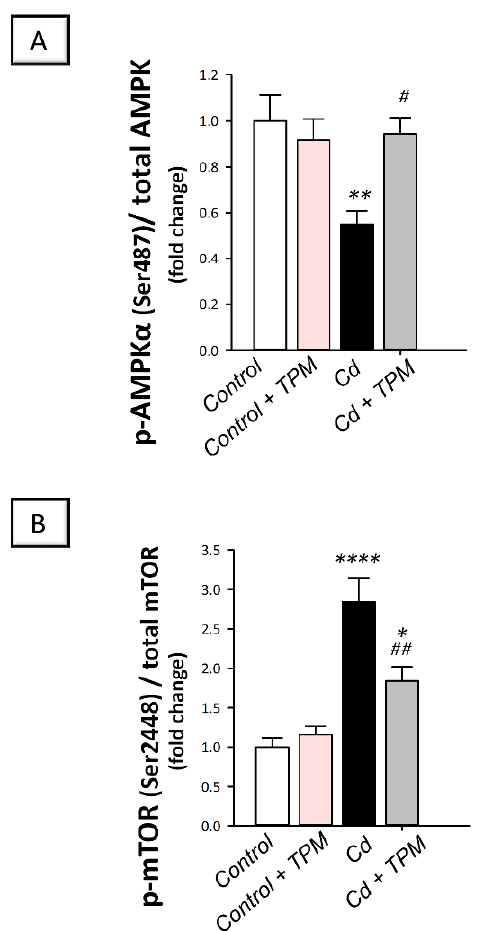
Figure 8. Effect of cadmium and/or topiramate on AMPK/mTOR pathway in testes of rats. The co-treatment with topiramate activated the testicular pro-autophagy AMPK/mTOR pathway that was inhibited by cadmium administration. This was manifested by increased p-AMPK (Ser487)/total AMPK ratio [H (3, 20) = 5.71, p = 0.0054] ( A ) and lowered p-mTOR (Ser2448)/total mTOR ratio [H (3, 20) = 18.83, p < 0.0001] ( B ). Results are demonstrated as the mean ± standard error of the mean (SEM) for six rats in each experimental group. * p < 0.05, ** p < 0.01, **** p < 0.0001 signifies statistical significance versus the control group; # p < 0.05, ## p < 0.01 signifies statistical significance versus cadmium chloride-treated group. AMPK, AMP-activated protein kinase; mTOR, mammalian target of rapamycin. TPM, topiramate; Cd, cadmium